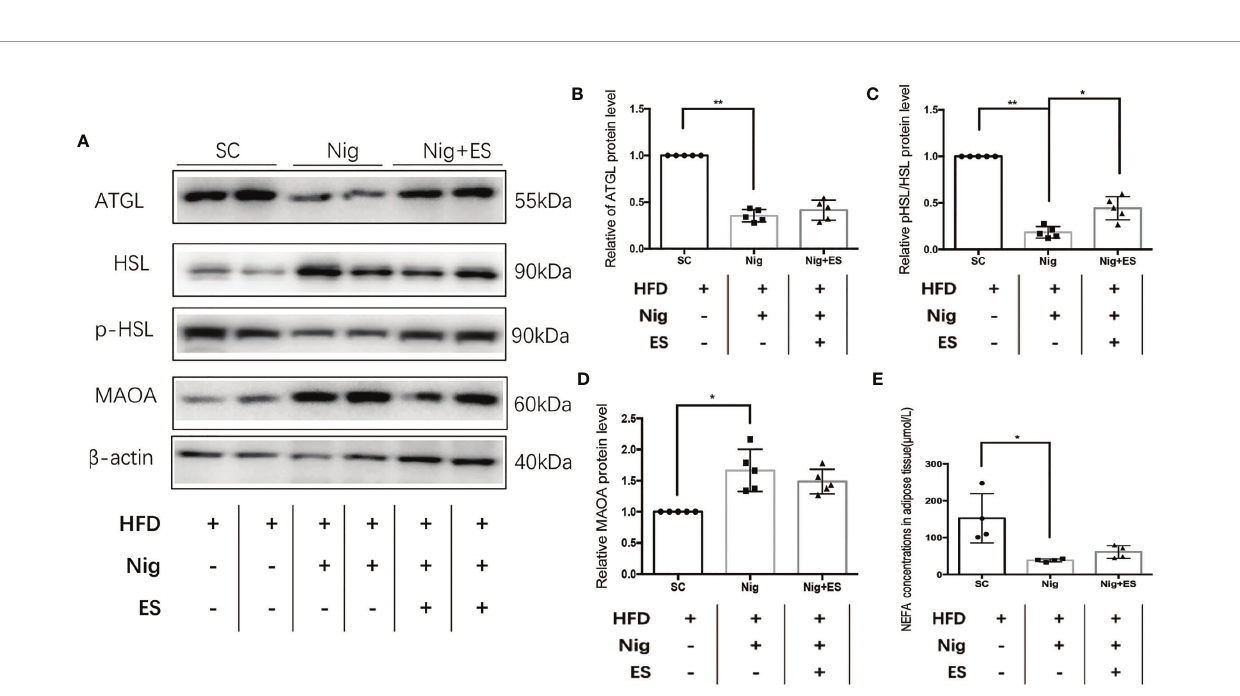
FIGURE 8 | NLRP3 in fl ammasome agonist suppressed ES-mediated lipolysis. (A) Immunoblot image showing ATGL, HSL, p-HSL, and MAOA in the SC, Nig, and Nig+ES groups. (B) Relative ATGL protein expression in eWAT (n = 5, ** P < 0.01). (C) Relative p-HSL/HSL protein expression in eWAT (n = 5, ** P < 0.01, * P < 0.05). (D) Relative MAOA protein expression in eWAT (n = 5, * P < 0.05). (E) NEFA concentrations in eWAT (SC, Nig, and Nig+ES groups, n = 4, * P < 0.05).